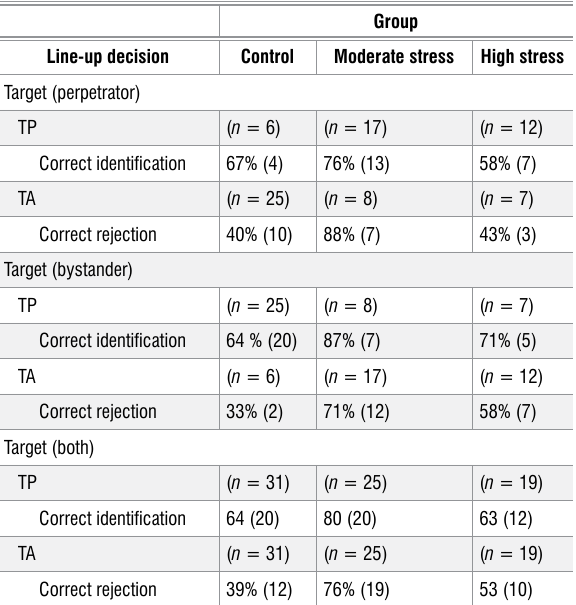
Descriptive statistics for Experiment 2 by group, line-up and perpetrator